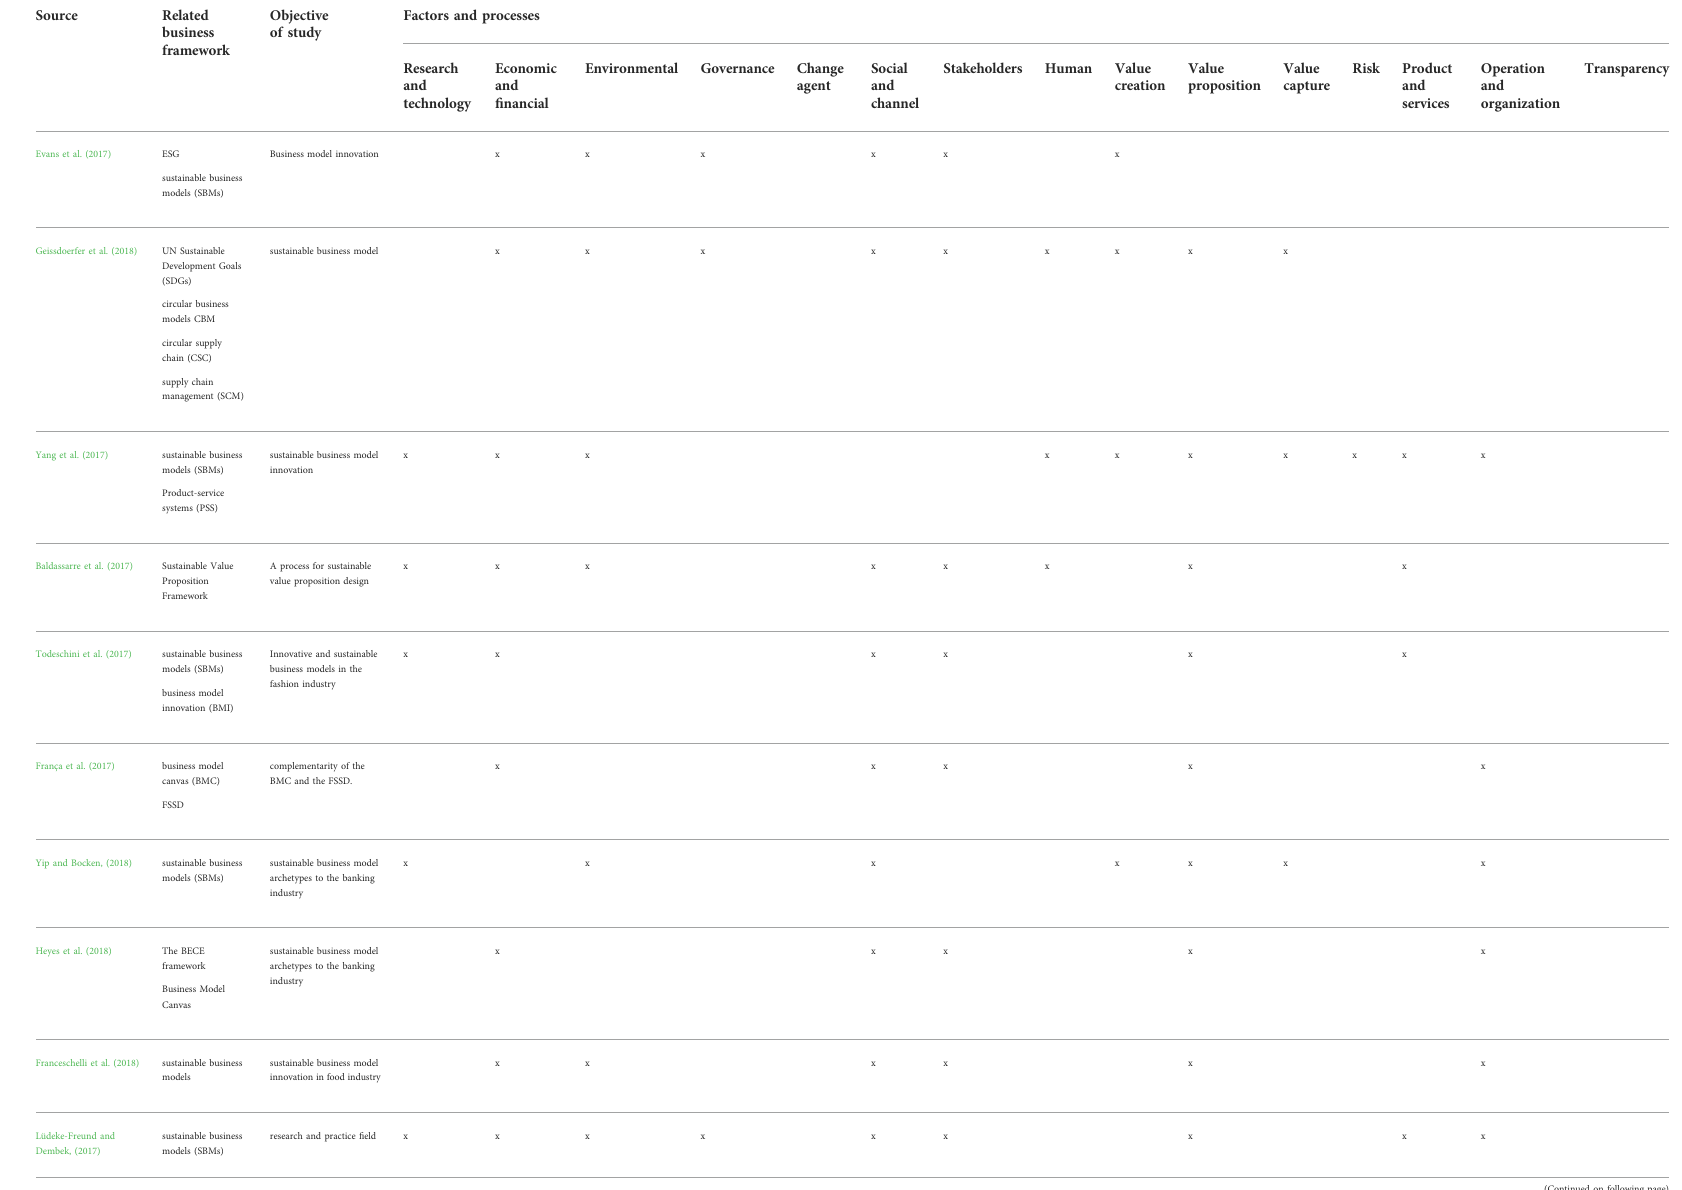
TABLE 6 A review of the literature for comparison and